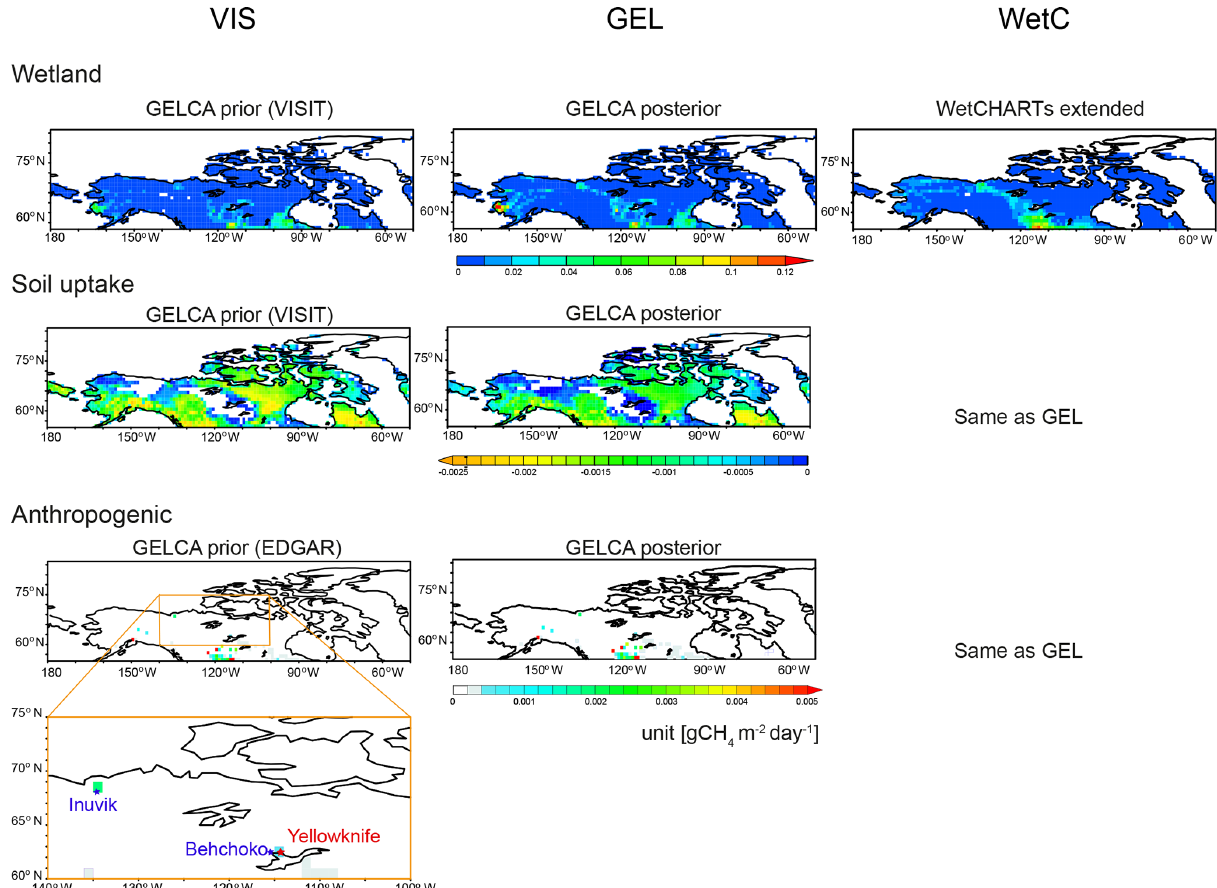
Figure 5. Spatial distributions of summertime prior CH 4 fluxes of wetland emission, soil uptake, and anthropogenic emissions for the three cases of prior fluxes, VIS, GEL, and WetC, which are listed in Table 2. The bottom left panel is a zoomed anthropogenic emission distribution in Northwest Territories. The locations of two sites, Behchoko (BCK) and Inuvik (INU), and the capital city, Yellowknife, are also